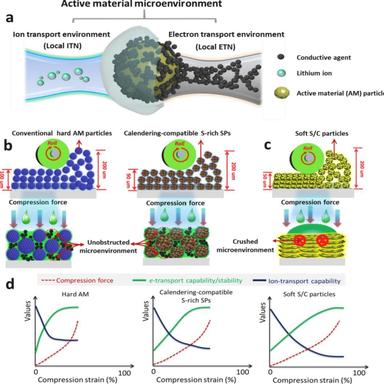
The propsoed active material microenviroment model for understanding the role of calendering process in controlling the quality of high-capacity thick electrodes. (a) Illustration of the active material microenviroment model in composite electrodes. (b) and (c) Schematic of the role of active material mechanical properties (calendering-compitability) in controlling the active material microenvironment during calendering process for hard active materials (NCM electrode and the sulfur SP@HSN electrode) and so